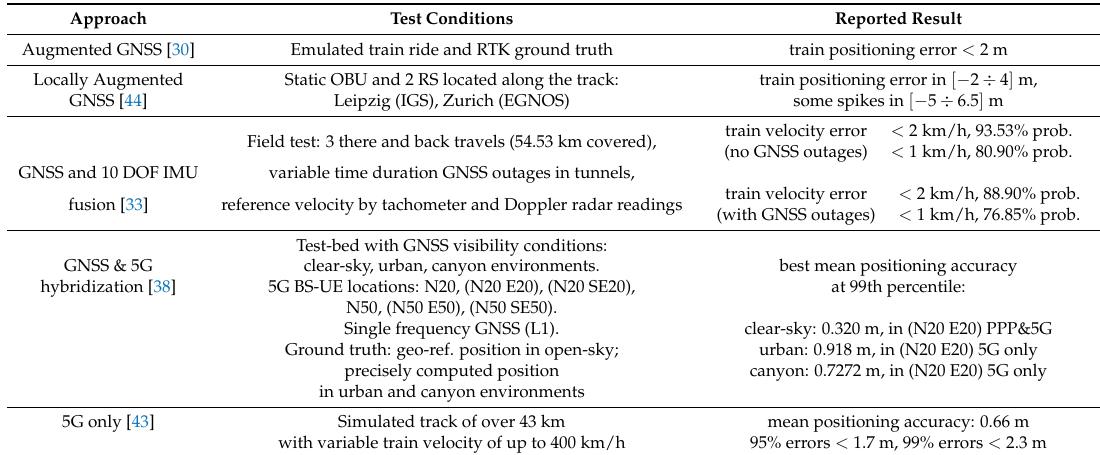
Table 3. Summary of train positioning approaches and reported